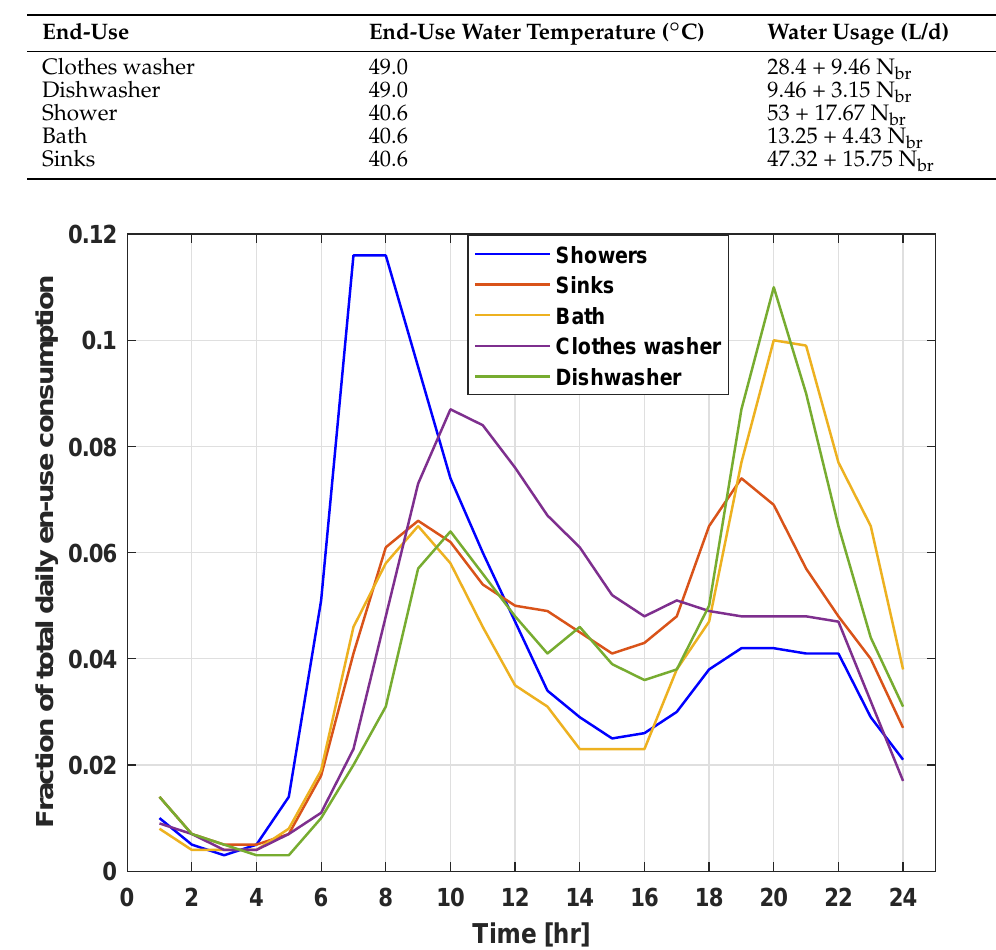
Figure 6. Typical hot water usage profile